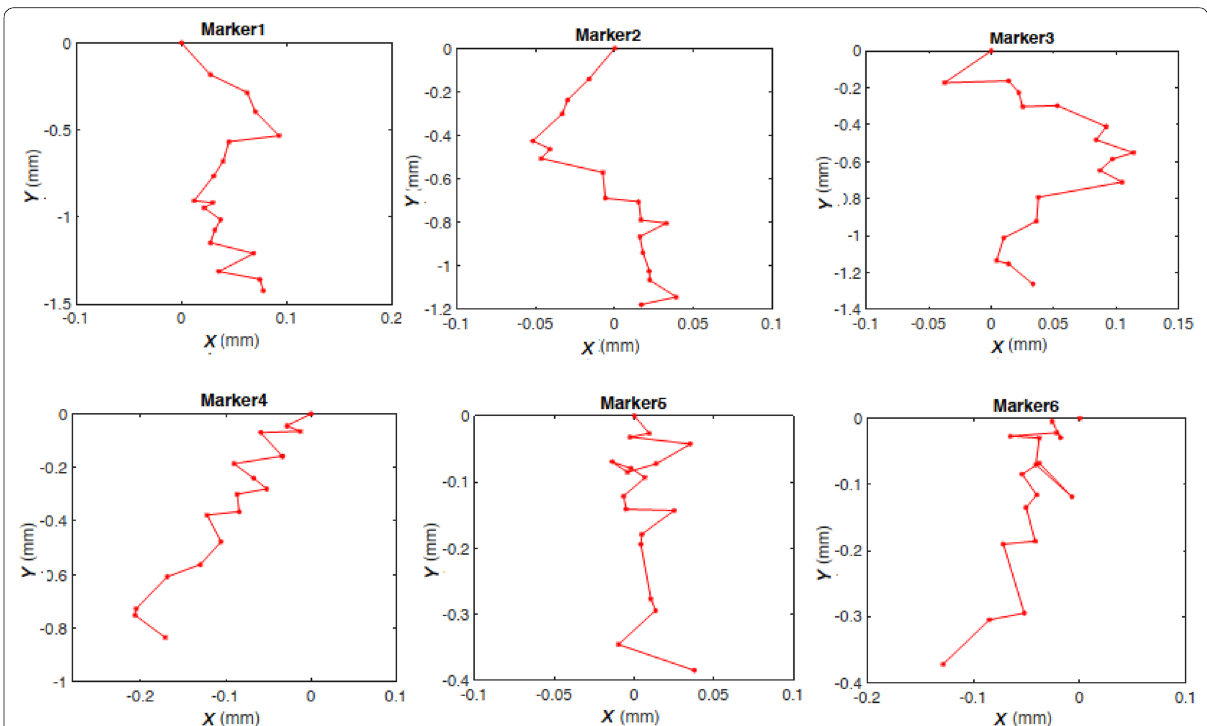
Figure 8 Trajectory of six markers during needle insertion